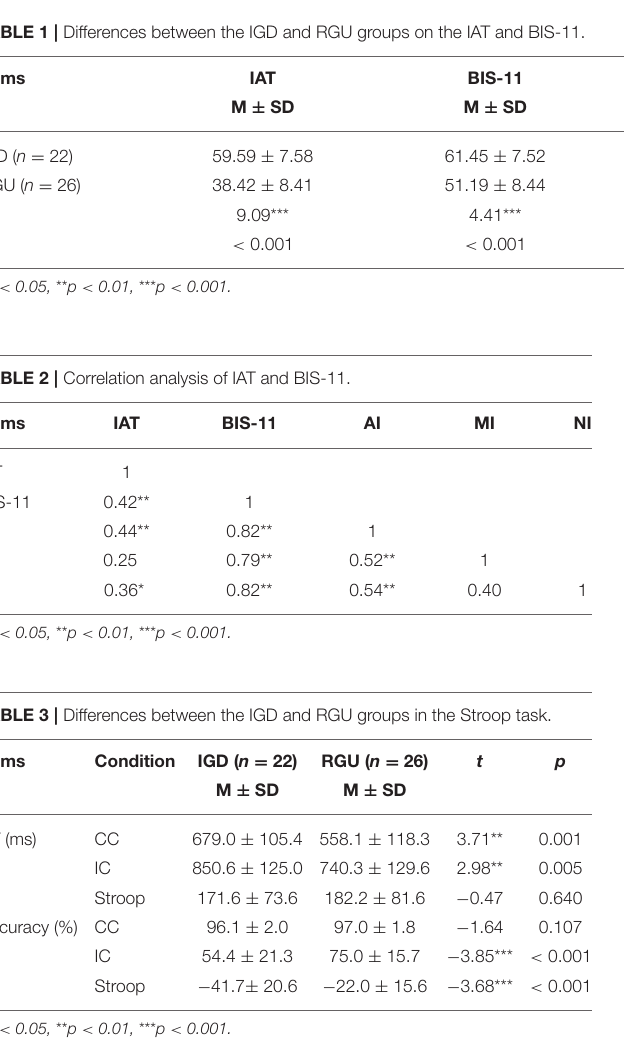
TABLE 1 | Differences between the IGD and RGU groups on the IAT and BIS-11. Items